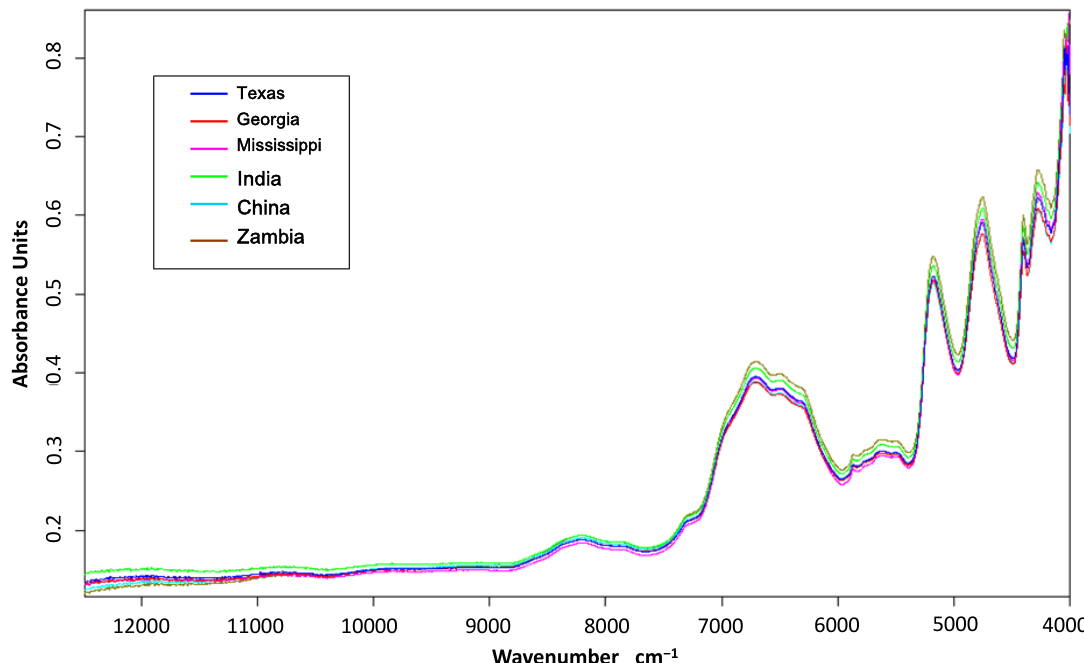
Figure 1. Representative NIR absorbance spectra of U.S. and international